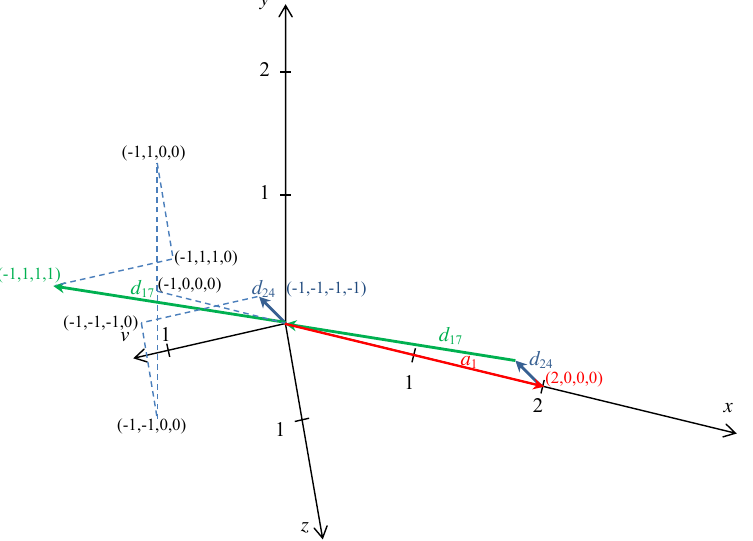
Figure 1. The sum of vectors a 1 , d 17 , and d 24 is the four-dimensional zero vector. The coordinates of the construction are also